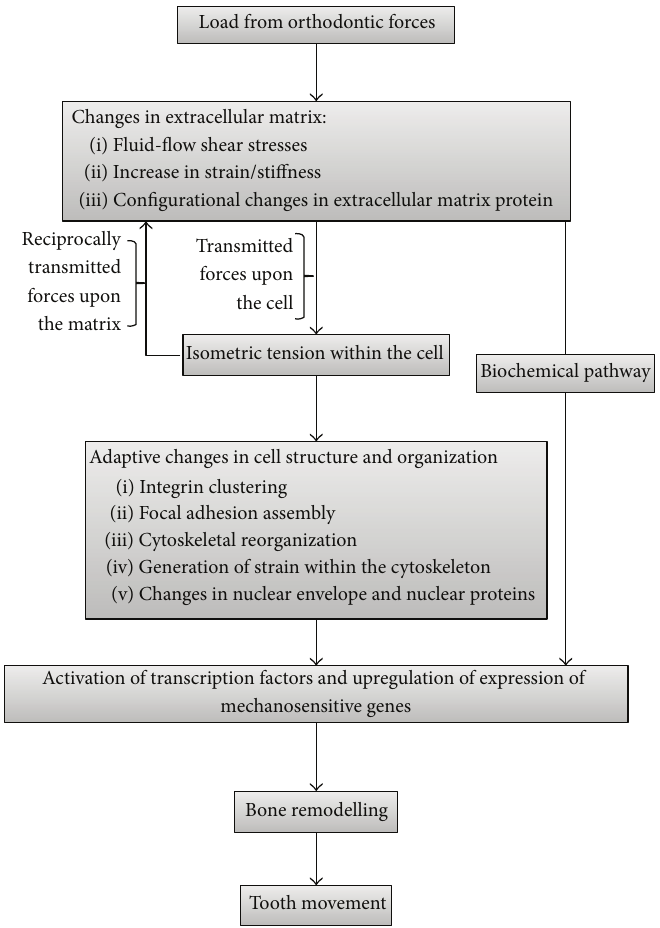
Figure 3: Flowchart showing some of the cell-matrix interactions inducing bone remodelling with consequent tooth movement.